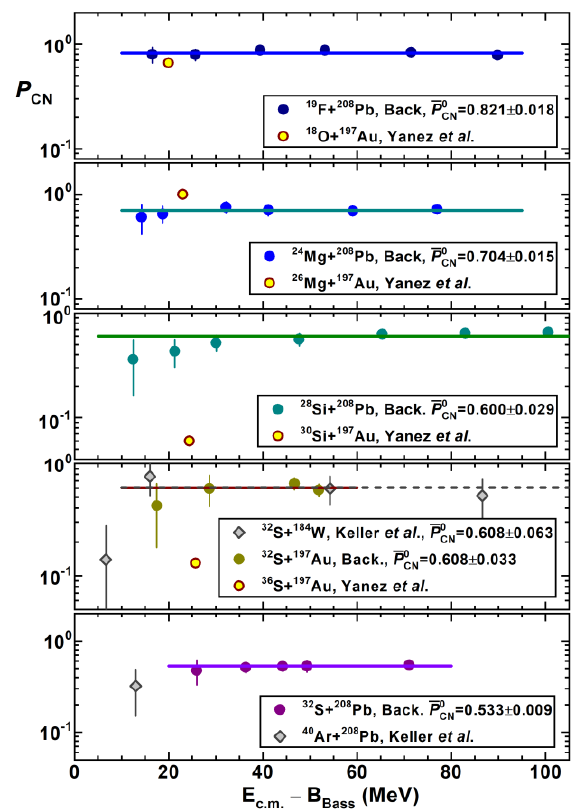
Fig. 1. P CN values (symbols) derived from fission studies in reactions with W, Au, and Pb targets [8] are shown as a function of an excess of the interaction energy over the Bass barrier [10]. A constant fit to the data (lines) and appropriate mean values are also indicated.